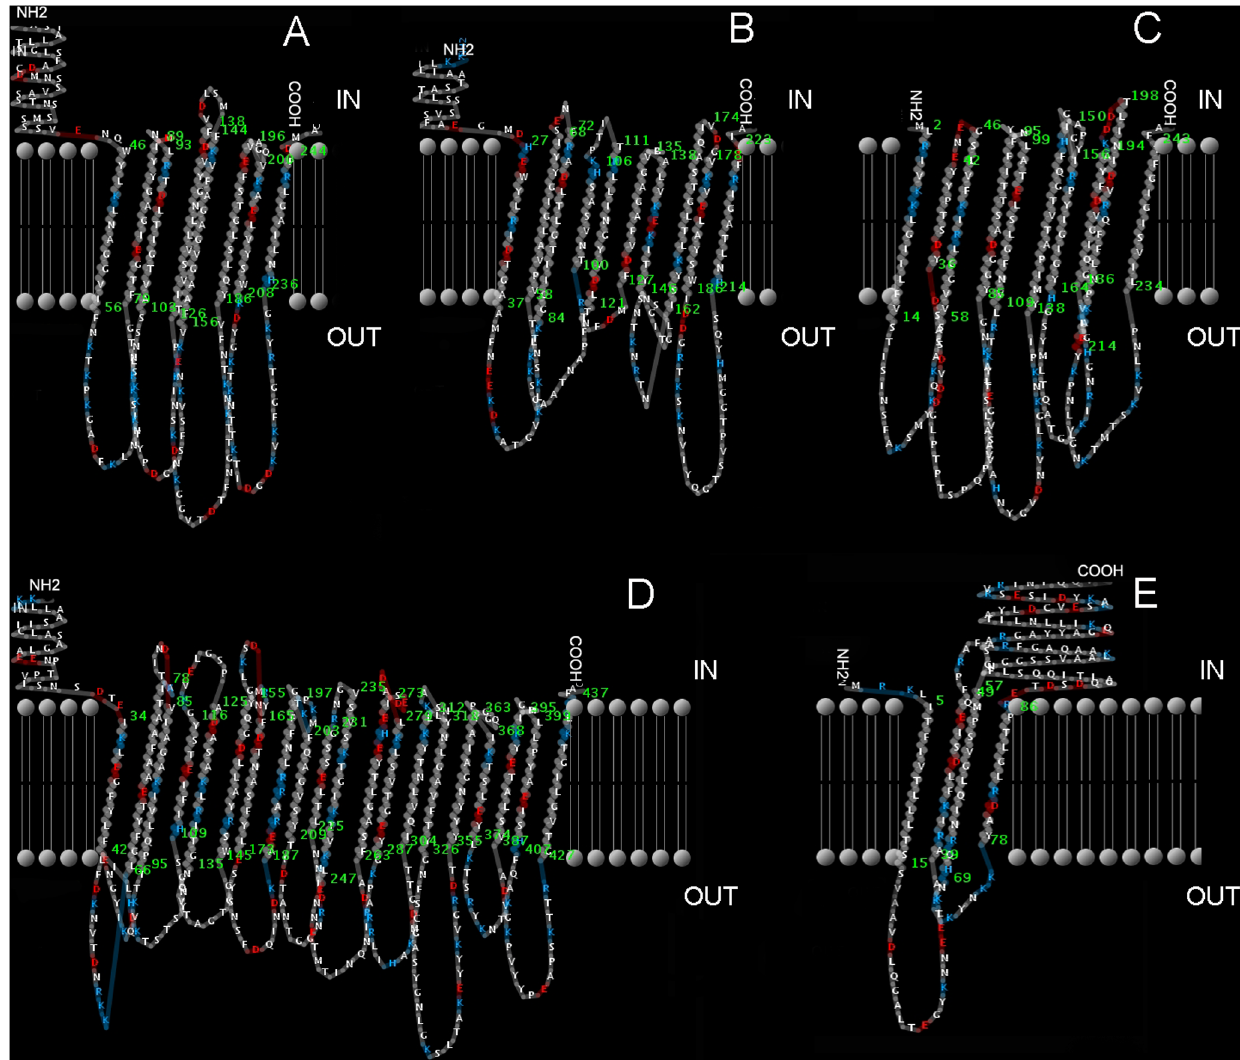
Figure 2. 2-D transmembrane structures of surface-exposed proteins predicted using the PRED-TMBB server. The 2-D transmembrane structures of Adr1(A), Adr2 (B), OmpW (C), Porin_4 (D), and TolC (E) of R. rickettsii were designed by the transmembrane protein representation in 2 dimensions (TMRPres2D) tool according to their amino acid sequences, respectively. Coloring based on the charge and electric potential (assuming pH=7): blue represents the negatively charged amino acids, red represents the positively charged amino acids, and gray indicates the neutral amino acids. IN means intracellular membrane, OUT means outer membrane, gray ball and double lines represent the lipid bilayer, the green numbers represent the amino acid ID inside or outside of the cell membrane; NH 2 and COOH represent the amino and carboxy terminus, respectively.